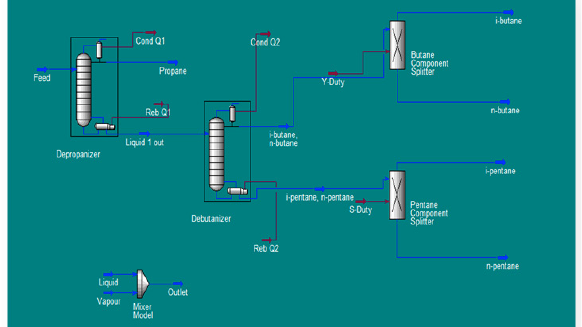
Figure 1. Process flow diagram for single feed multicomponent